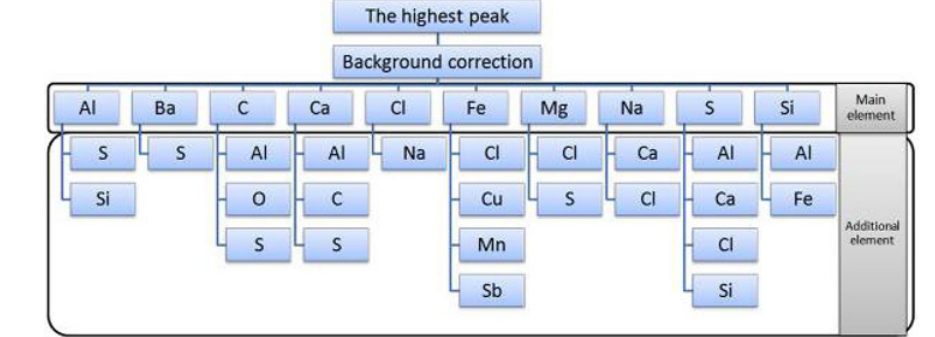
Figure 2. Scheme of particle classification